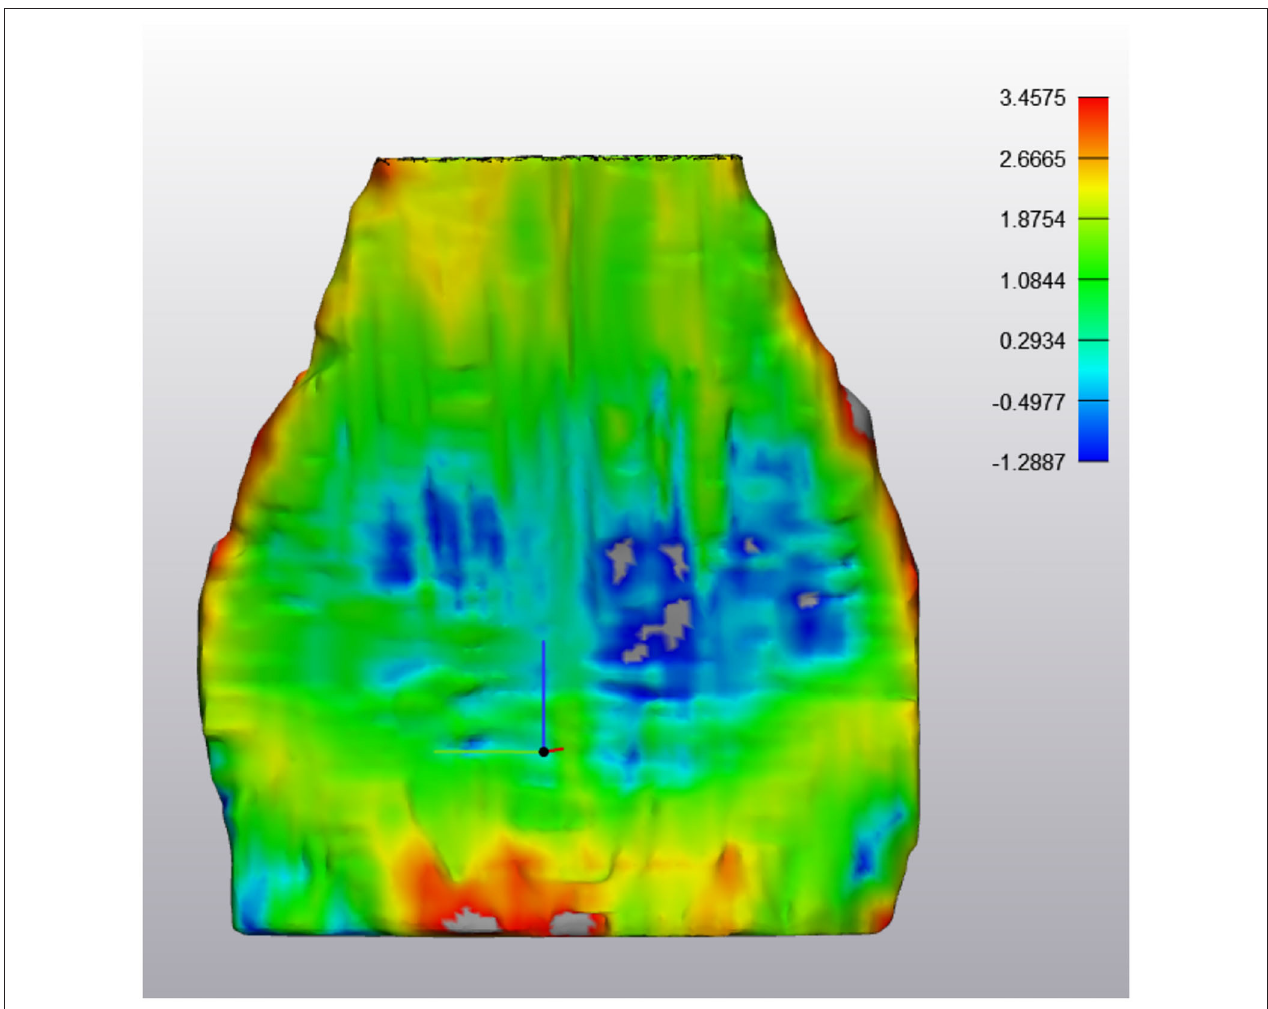
FIGURE 7 | ABNORMAL Deep Digital Flexor Tendon. In this image, thinning has occurred in the mid region of the DDFT as it courses around the navicular bone over a 6 month period. However, both proximally (yellow) and distally (red) there is an increased in tendon thickness, indicating a dynamic volumetric response to tendon injury. Top of the image represents the proximal aspect of the